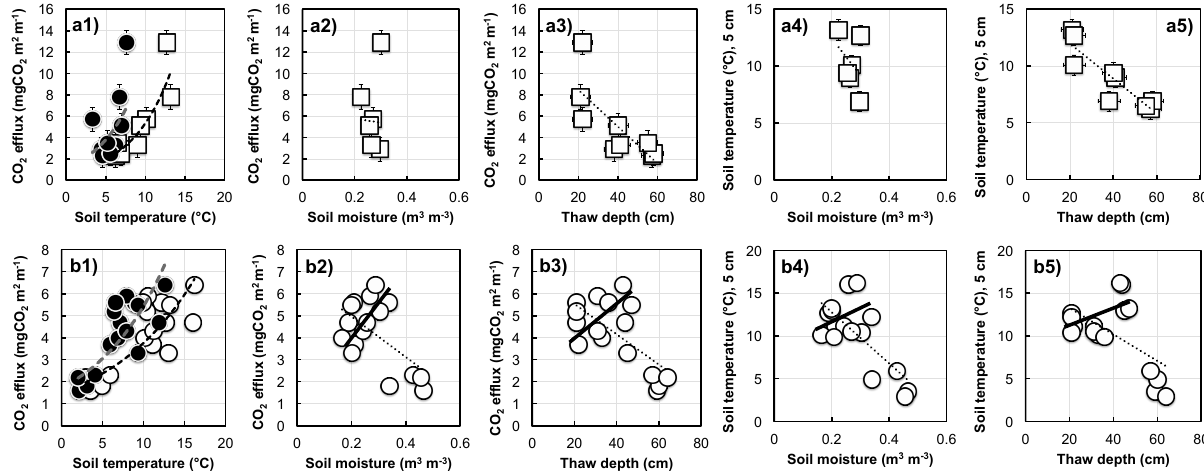
Figure 3. Responses from monthly average CO 2 efflux to (1) average soil temperature at 5 and 10cm (open and solid circles), (2) average soil moisture, and (3) thaw depth, as well as responses from average soil temperature at 5cm to (4) average soil moisture and (5) average thaw depth during the growing seasons of (a) 2011 and (b) 2012. Dashed curves ( a1 and b1 ) and dotted lines indicate the negatively linear relationship between the two. Furthermore, solid lines in b2–5 denote the positively linear relationship between factors, except for data measured in